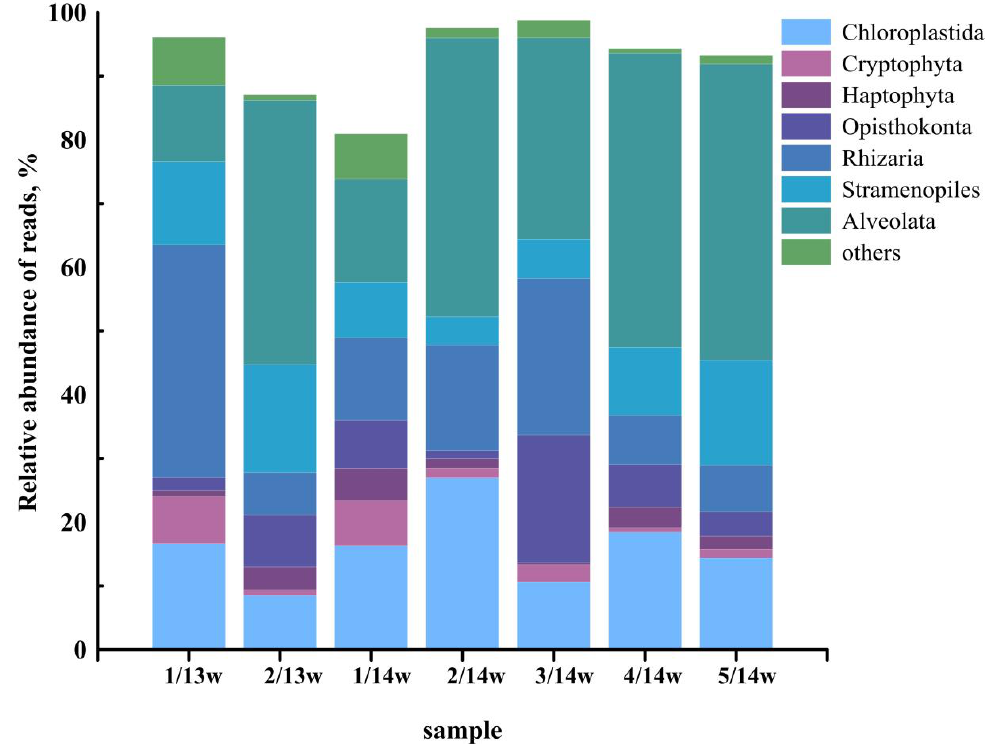
Figure 2. The relative abundance (%) of V4 rDNA reads of the major protist groups in picoplankton Figure 2. samples.